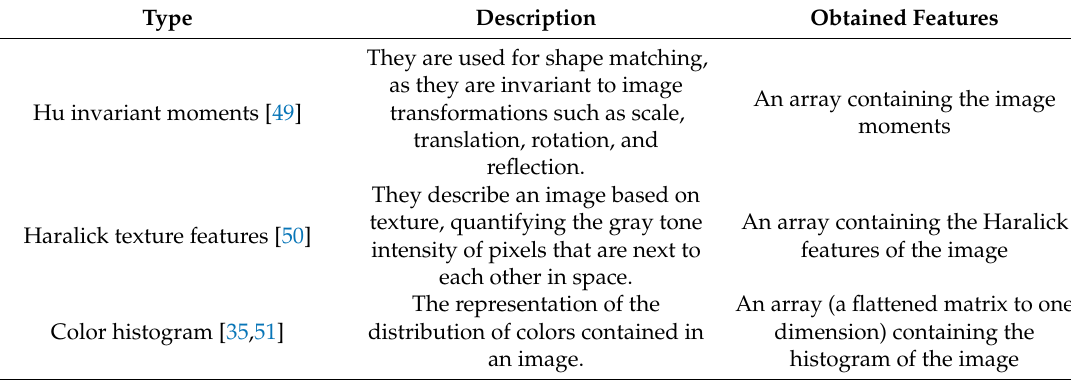
Table 2. Extracted global features from each